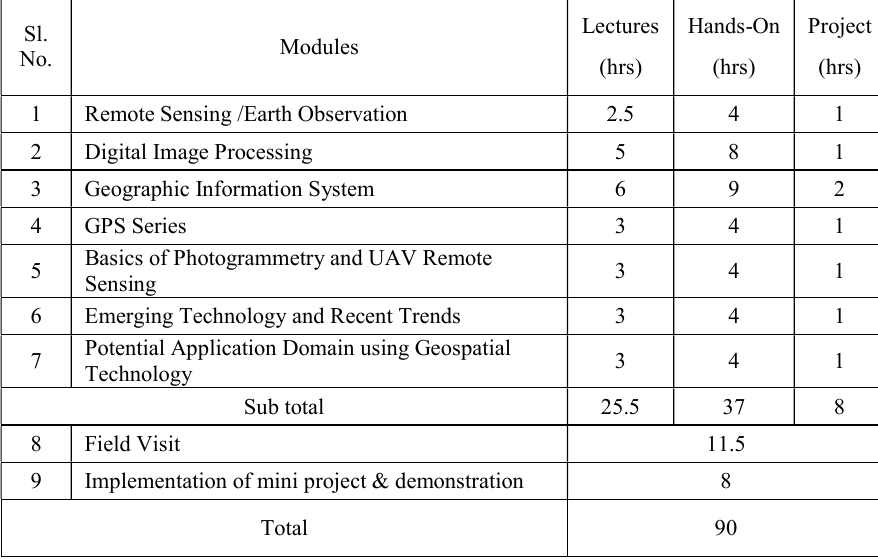
Table 1. Module-wise allocation of time (hrs) for lecture/hands-on series etc.